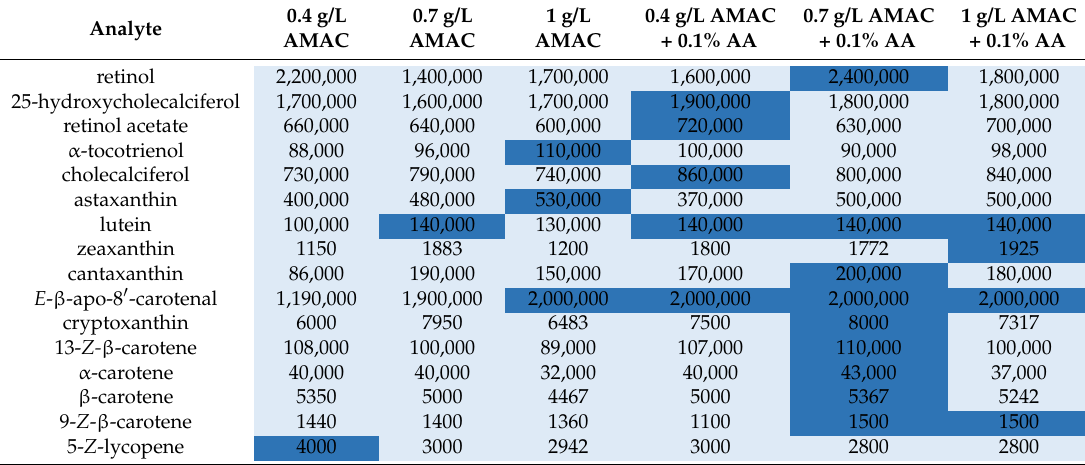
Table 1. Influence of LC solvent additives (0.4 g/L ammonium acetate (AMAC), 0.7 g/L AMAC, 1 g/L AMAC, 0.4 g/L AMAC + 0.1% AA, 0.7 g/L AMAC + 0.1% AA, 1 g/L AMAC + 0.1% AA) on MS signal